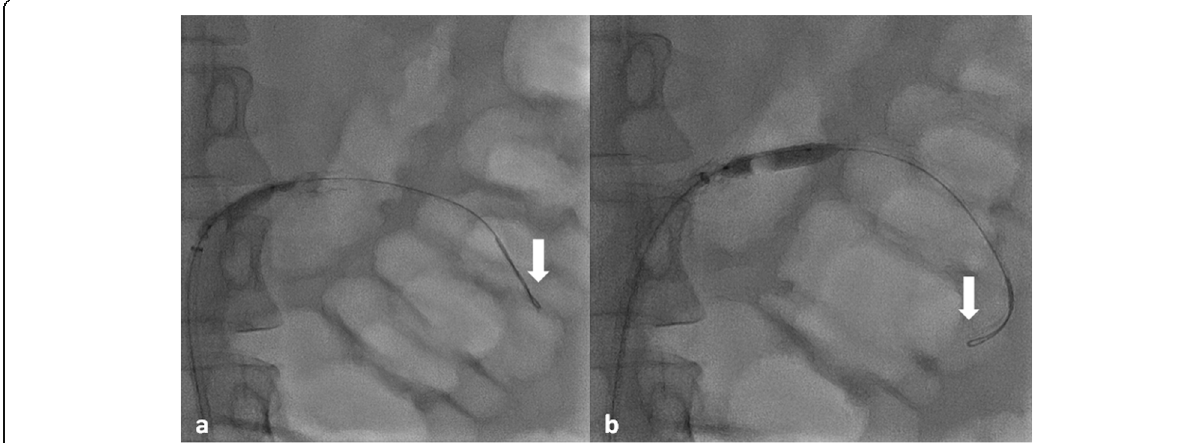
Fig. 2 a Balloon angioplasty of the origin of the renal artery and proximal stent segment, followed by 2nd balloon inflation more distally within the stent and the renal artery ( b ). Note the accidental distal migration of the guide wire (arrows)